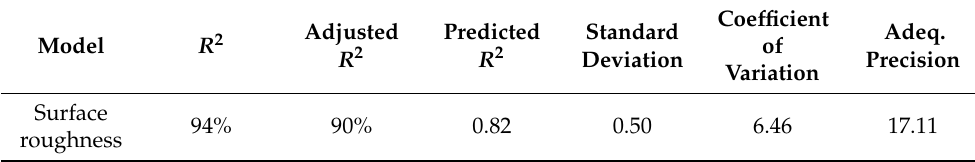
Table 7. Fit summary of the surface roughness